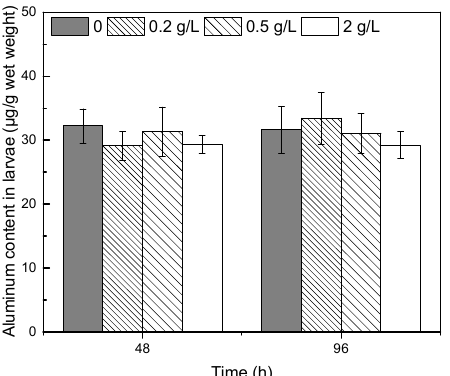
Figure 6. Changes in the aluminum content in larvae. Mean ± SD; ANOVA, Tukey.